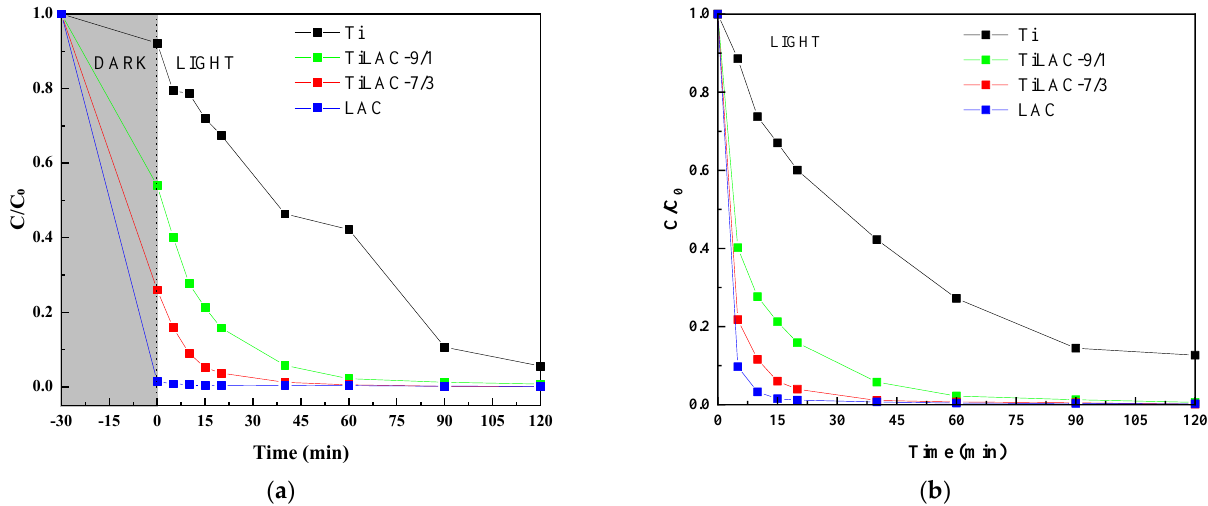
Figure 7. Methylene blue removal on Titania P25 (Ti) and TiLAC based catalysts; ( a ) under dark and UV-irradiation; ( b ) under UV-irradiation without the first phase of adsorption equilibrium; with C (MB) = 6.0 × 10 −5 M, catalyst dosage = 1.25 g·L −1 at 25 °C.